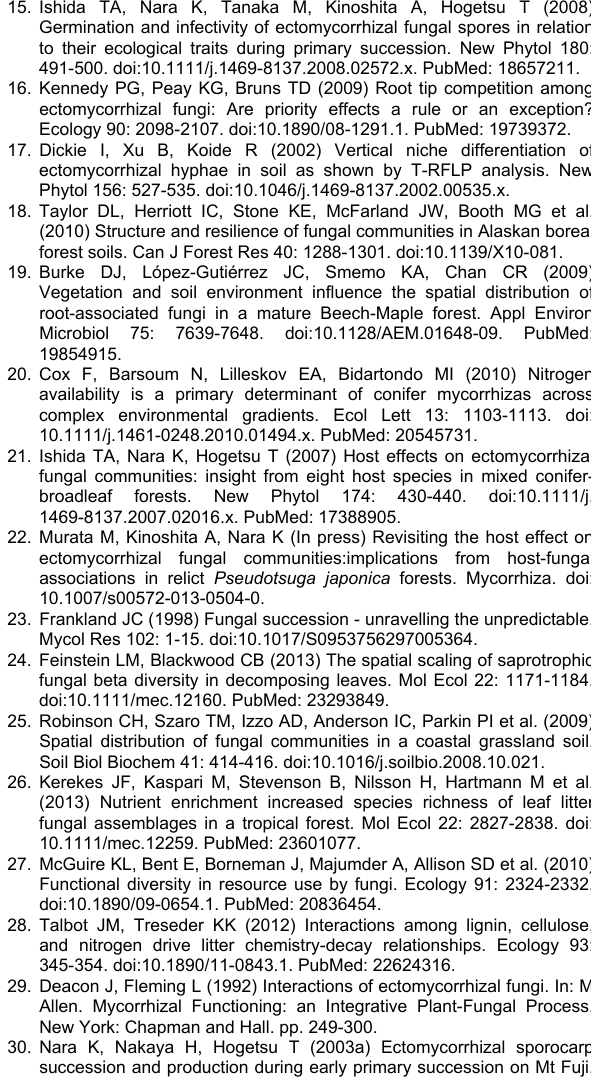
Tables S3. Fungal OTU numbering list.